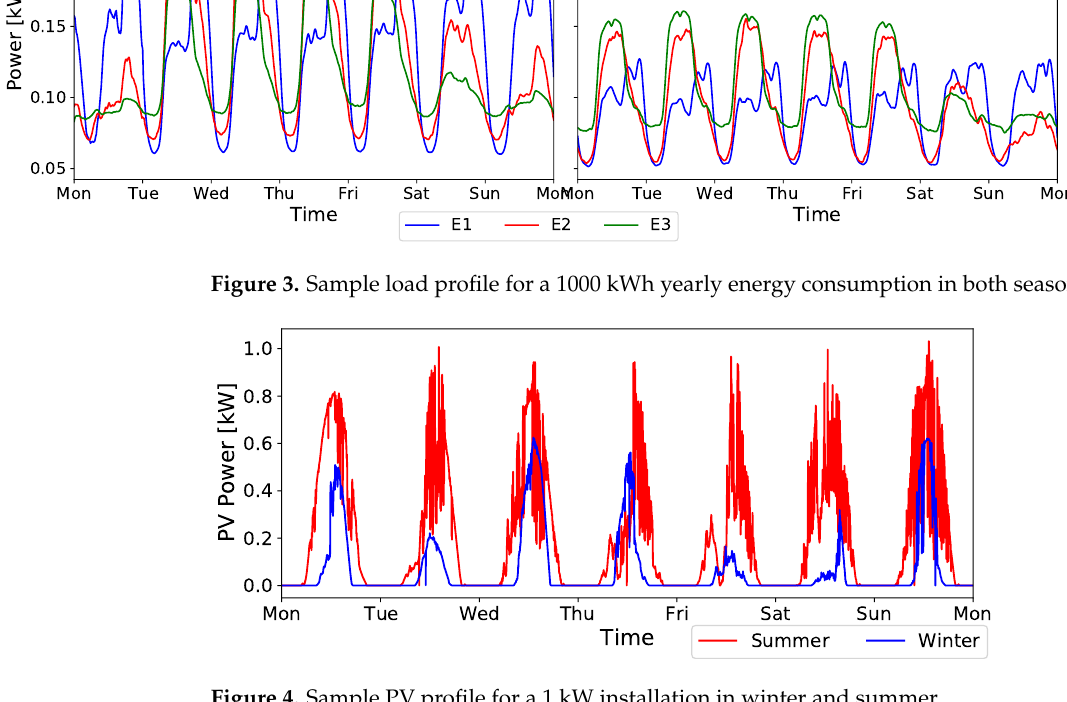
Figure 4. Sample PV profile for a 1 kW installation in winter and